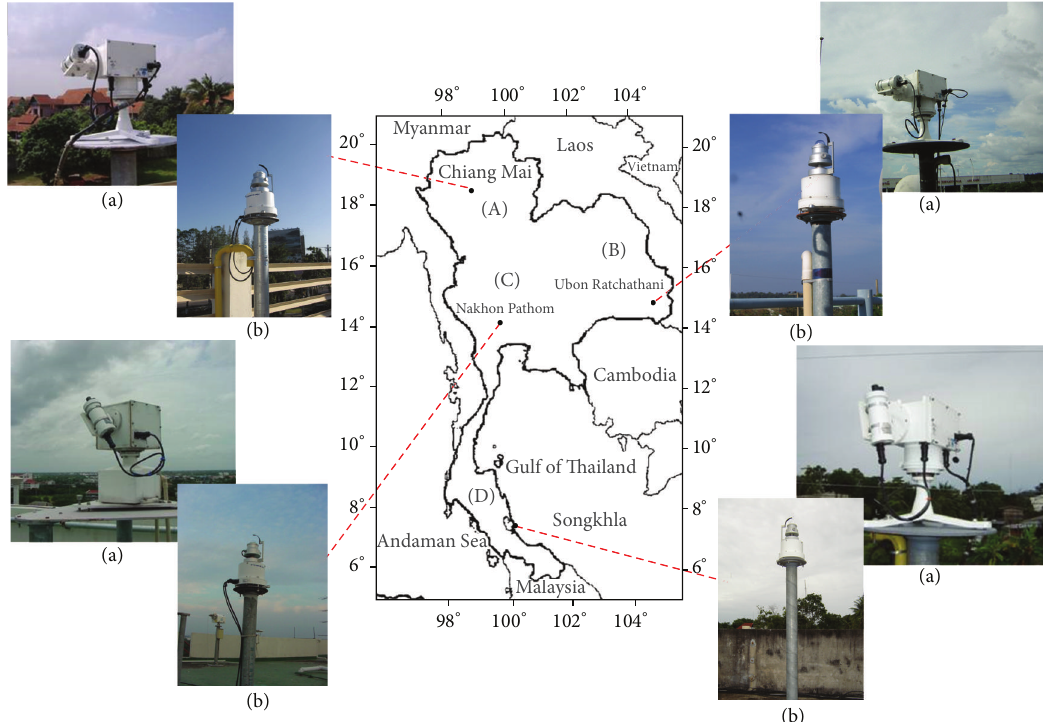
Figure 1: Pictorial view of the sky scanners (a) and sky cameras (b) and positions of the sky luminance measurements. A, B, C and, D indicate the northern region, northeastern region, central region and the southern region,